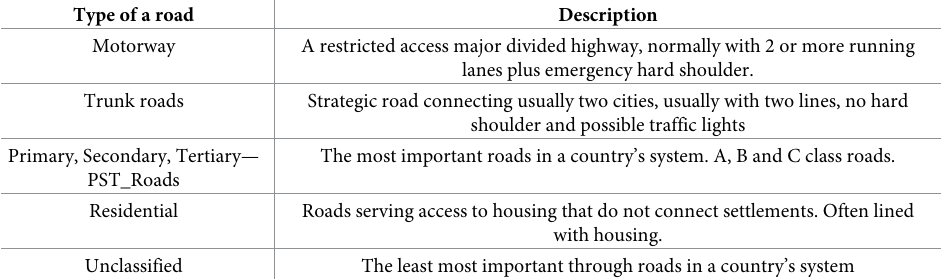
Table 6. OSM road classification adjusted for the purposes of this paper. Source OSM Wiki.